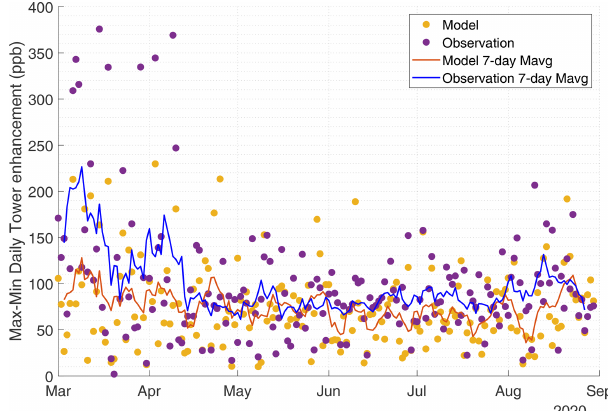
Figure 3. Comparison between modeled and observed differences in the maximum and minimum daily CH 4 enhancement across the tower network. Also shown are the 7d moving averages (Mavg) of each